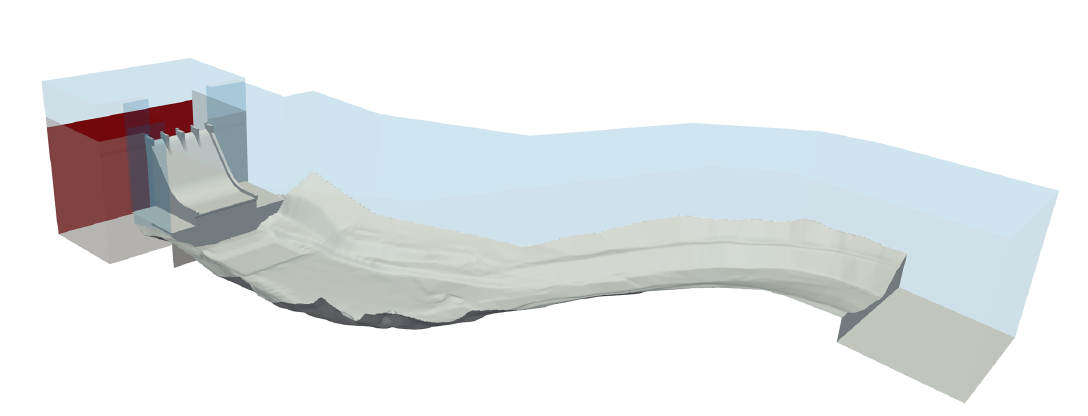
Figure 11. Geometry model of the configuration in the absence of the downstream dam. The light blue transparent region denotes the computational domain. The inflow section is highlighted in